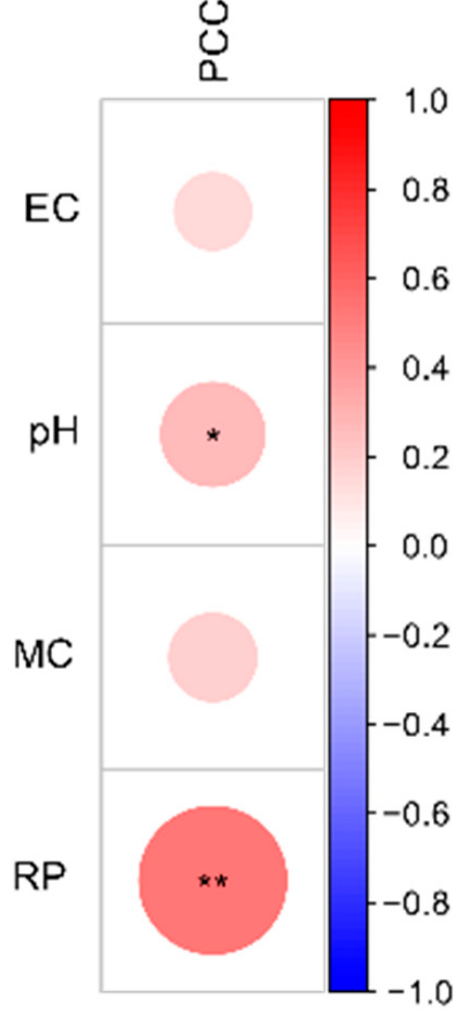
Figure 3. Correlation between soil properties and bacterial communities by the Mantel test. The scale bar indicates the Pearson correlation coefficient (PCC). Blue denotes − 1, whereas red denotes 1. Asterisks indicate significant correlation (* p < 0.05; ** p < 0.01). EC—electric conductivity; MC— moisture content; RP—redox potential.